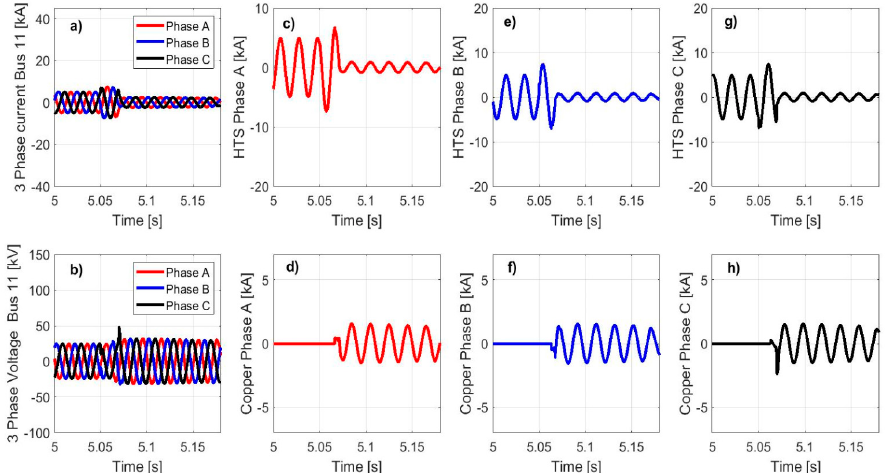
Figure 17. Fault current signatures for 3-Phase-to-ground fault at 50% of cable’s length: with 𝑅 𝑓2 = 5 Ω ( a ) phase currents at Bus 11, ( b ) phase voltages at Bus 11, ( c ) current in HTS layer of phase A, ( d ) current in copper layer of phase A, ( e ) current in HTS layer of phase B, ( f ) current in copper layer of phase B, ( g ) current in HTS layer of phase C, ( h ) current in copper slayer of phase C.